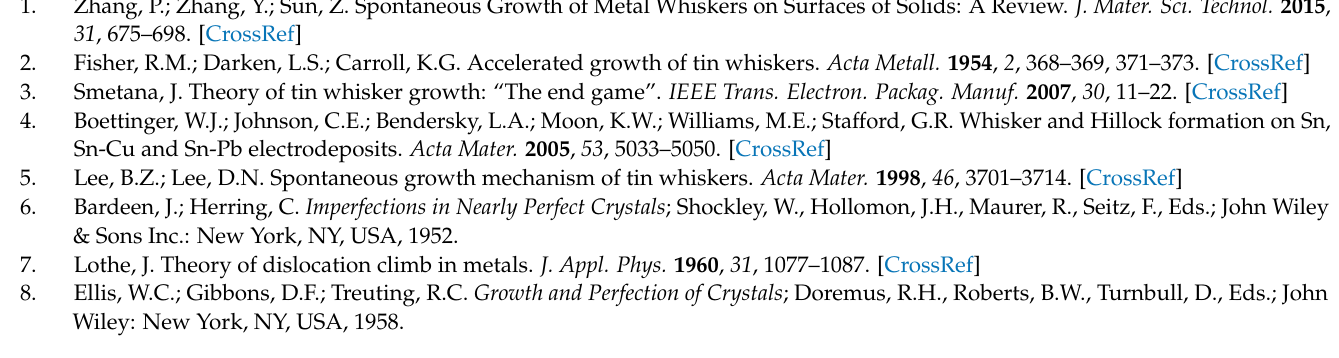
Figure S3: Additional SEM images of Bi-Mg-Pb pool exhibiting varying growth of hillocks based on the exposure to vacuum and ambient